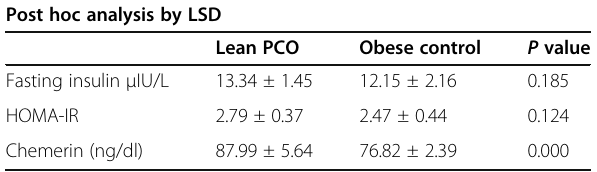
Table 4 Post hoc analysis (obese PCO and obese control) as regards fasting insulin, HOMA-IR and chemerin Post hoc analysis by LSD